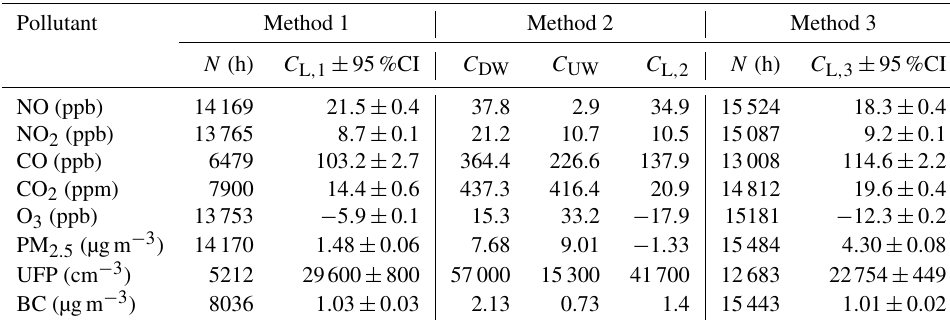
Table 2. Mean local pollutant concentrations at NR-TOR-1 determined using each background-subtraction method.